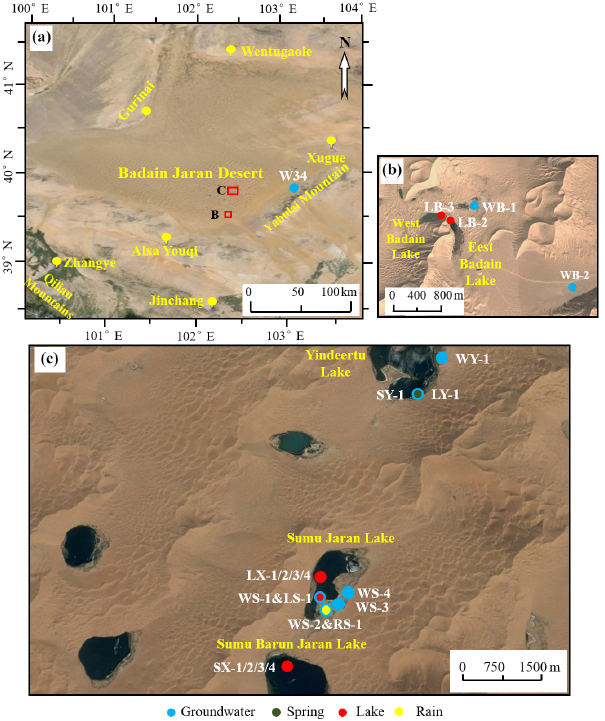
Figure 1. Maps showing location of the Badain Jaran Desert (a) , the Badain lake sampling area (b) and the Sumu Jaran lake sampling area (c) . W-34 in (a) is the sampling site of Gates et al.